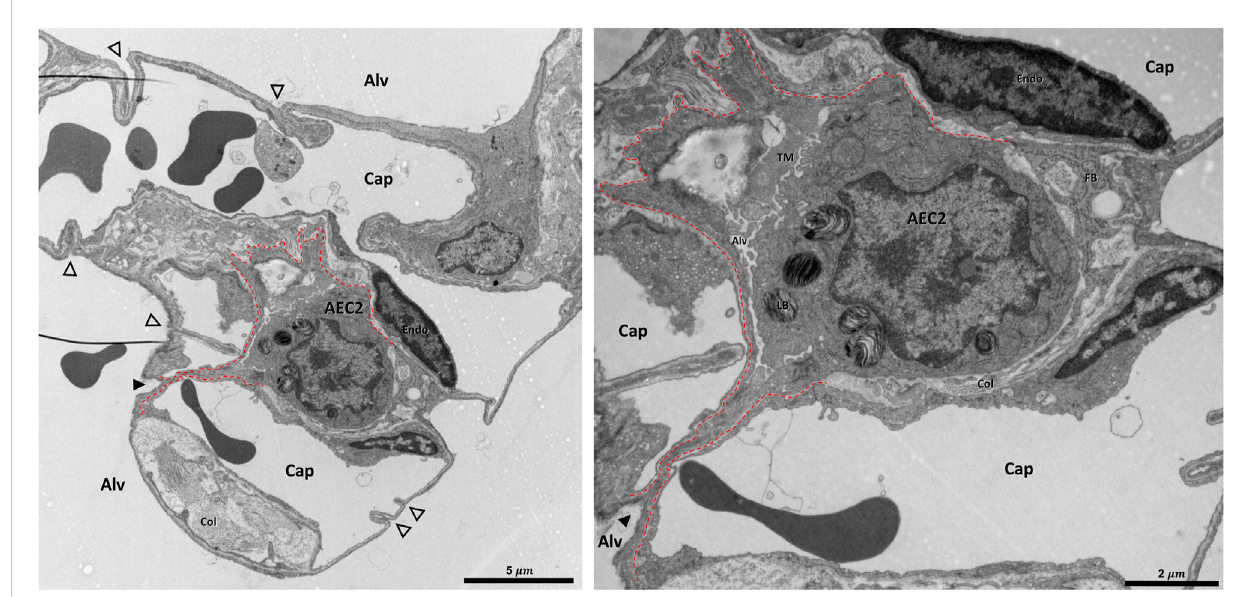
FIGURE 10 Pleatinvolvingmore componentsoftheinteralveolarsepta: Ahealthyratlung was fi xed invivo byvascularperfusion via thevenacava caudalis atan airway opening pressure of 5 cmH 2 O on expiration after two recruitment maneuvers (3 s pause at 30 cmH 2 O) (Knudsen et al., 2018). The alveolar airspaces (Alv) and the alveolar capillary network (Cap) is open but contains red blood cells. The capillaries are lined by endothelial cells (Endo). The fi lled arrowhead points at the entrance to a pleat, the black dashed line marks the run of the epithelial basement membrane into the pleat. The pleat is partly bordered by the apical plasma membrane of an alveolar epithelial type 2 cell (AEC2) with its characteristic organelle, the lamellar body (LB). Moreover, the pleat contains some fl uid and intraalveolar surfactant, represented by tubular myelin (TM). Underneath the AEC2, interstitial tissue is located, e.g. collagen fi brils (Col) and fi brobasts (FB) are visible. Note that two dark lines at left of left image are an artifact due to folding of the ultrathin section, not part of the tissue structure. The empty arrowheads point at pleats formed exclusively by the blood-gas barrier.